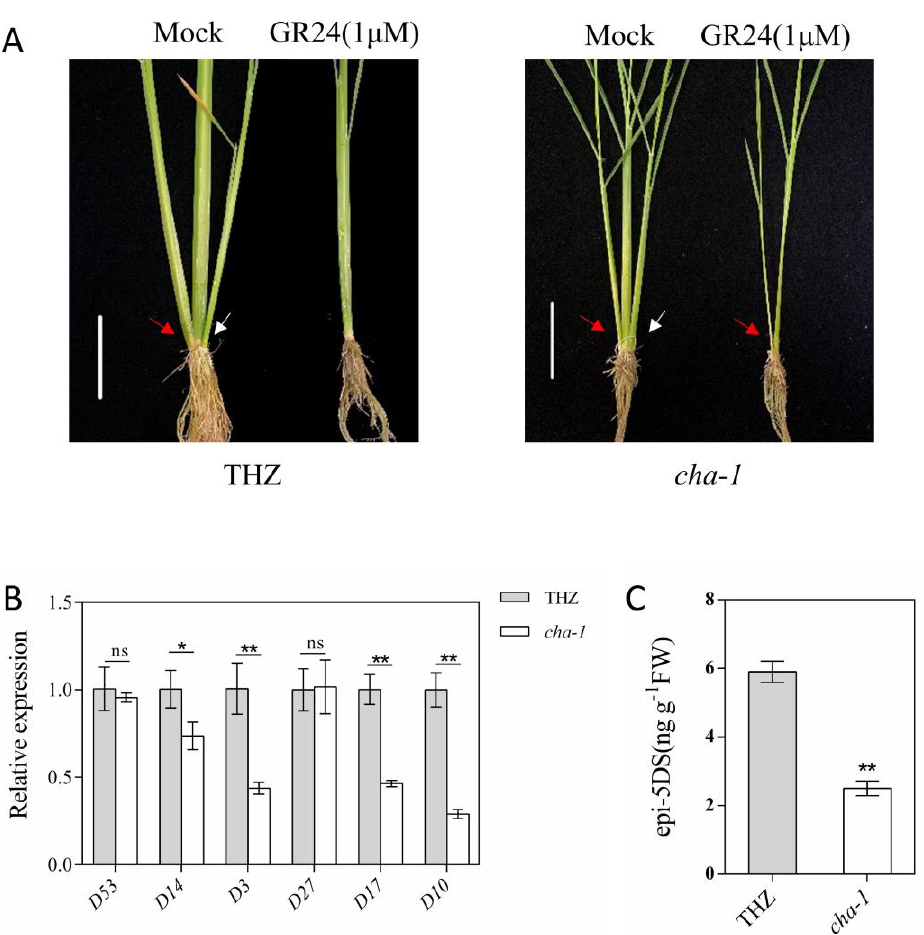
Figure 5. Effect of the partial loss-of-function allele of CHA-1 on SL biosynthesis. ( A ) Length of the tiller buds of THZ and CHA-1 treated with 1 µ mol GR24 for 4 weeks. GR24 is a synthetic strigolactone. Plants were treated without GR24 as mock-treated control. ( B ) Relative expression levels of SL pathway genes between THZ and CHA-1 . D53 , D14 , and D3 were SL signaling pathway genes. D27 , D17 , and D10 were SL biosynthesis pathway genes. ( C ) Comparison of epi-5DS contents in the THZ and CHA-1 root exudates. Values are the means ± SD. *, p < 0.05; **, p < 0.01; ns, no significance (Student’s t- test).